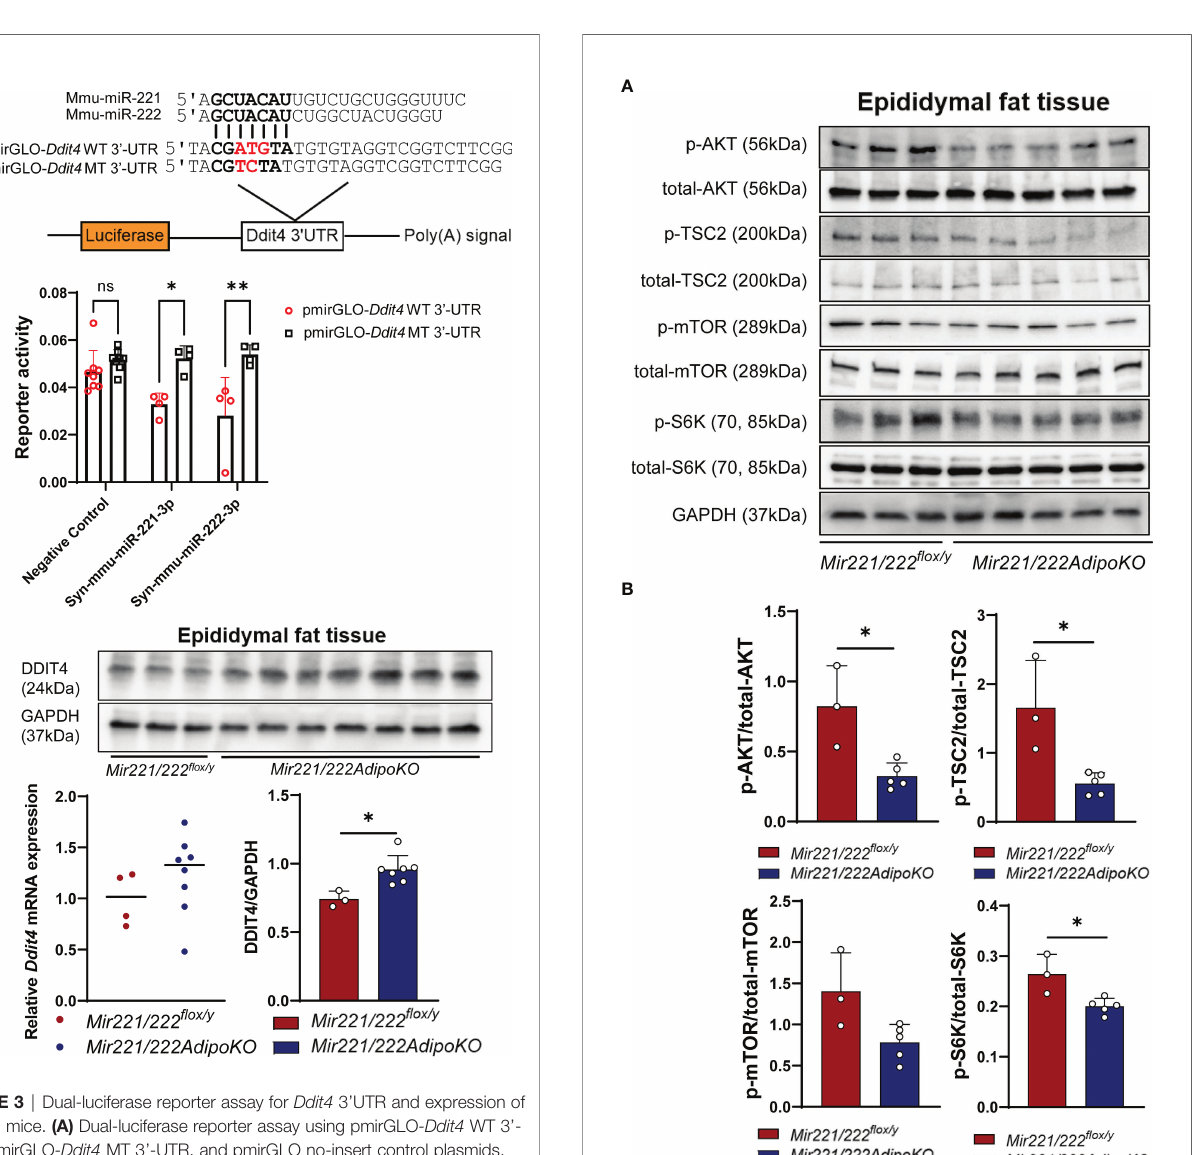
pLV-locker 221 and pLV-locker 222 ( Figure 5C ), while they were signi fi cantly up-regulated by treatment with pLV 222 ( Figure 5D ). To investigate lipolysis, lentiviral vectors were transduced to the fully differentiated 3T3-L1 adipocyte and we performed glycerol assay 7 days after lentiviral transduction.